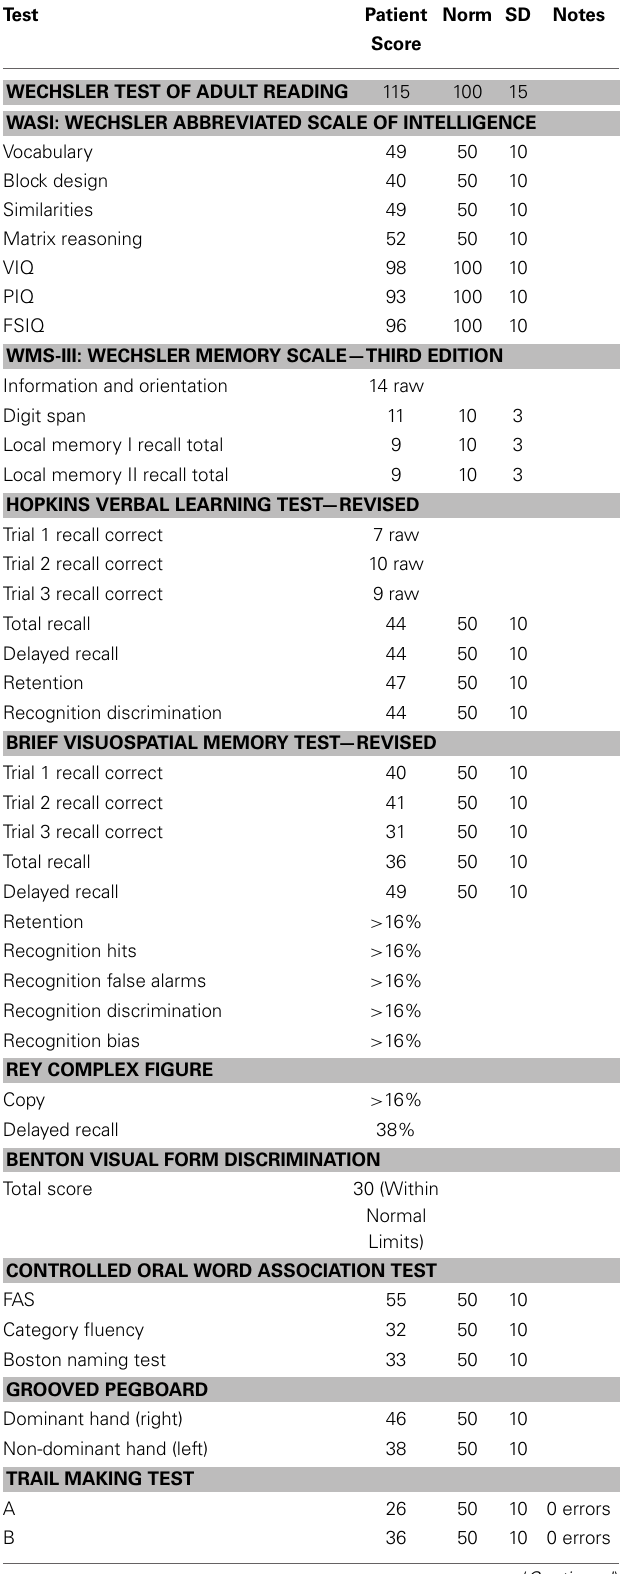
Table 1 | Results from neuropsychological tests administered to the